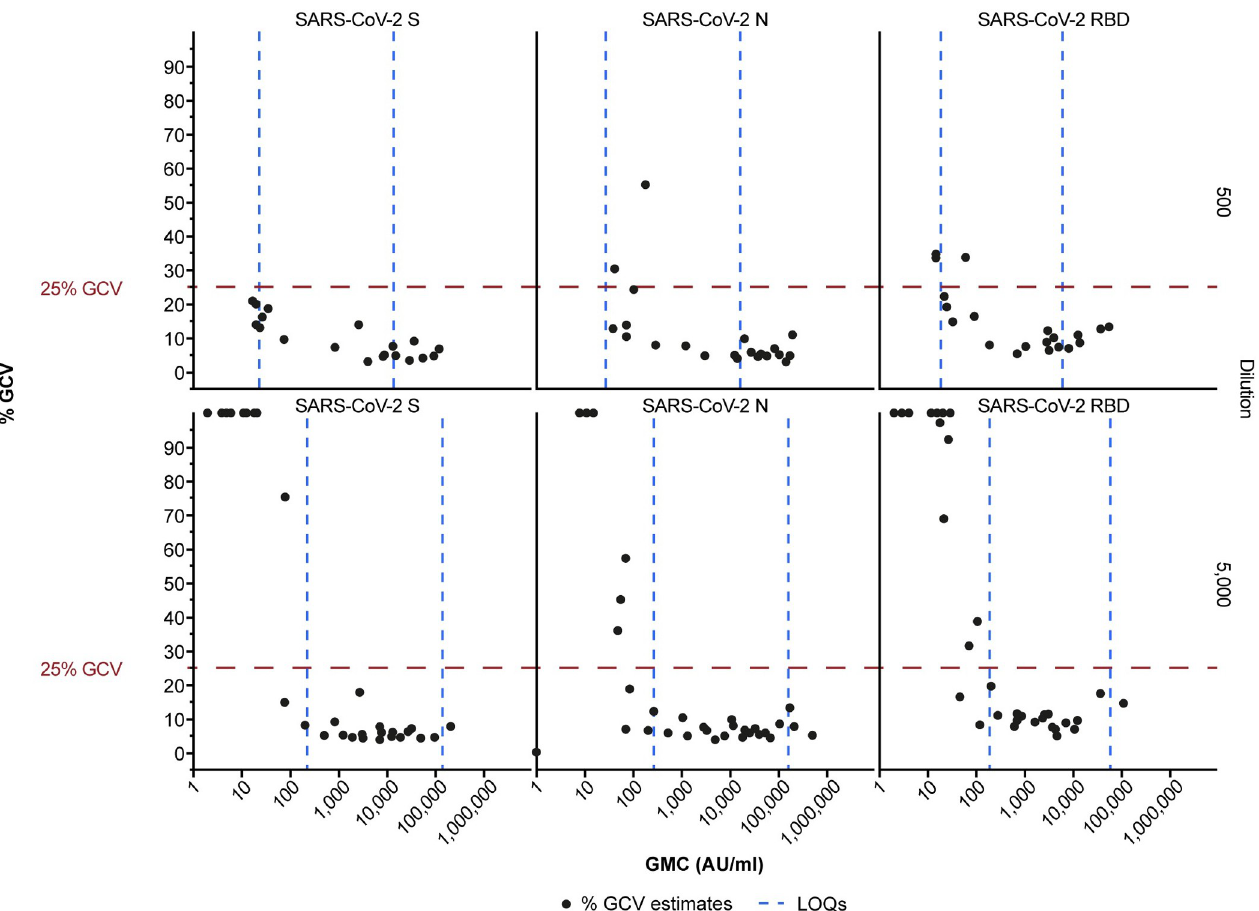
Fig 3. Anti-SARS-CoV-2 antibody MSD ECL assay precision. Precision profiles are shown for each of the three antigens in the assay, SARS-CoV-2 spike (SARS-CoV-2 S), nucleocapsid (SARS-CoV-2 N), and receptor-binding domain (SARS-CoV-2 RBD) across increasing geometric mean Ab[C]s (across 15 runs); precision profiles for quality control samples are also shown. The horizontal red dashed line represents the pre-defined %GCV criterion of � 25%. GMC values that exceeded the X-axis are displayed as the minimum or maximum value. %GCV values that exceeded the Y-axis maximum value are displayed at the top of the graph. The LLOQ and ULOQ are shown by vertical dashed lines. AU = arbitrary units; GMC = geometric mean concentration; %GCV = percent geometric coefficient of variation; LLOQ = lower limit of quantitation; LOQ = limit of quantitation; SARS-CoV-2 = severe acute respiratory syndrome coronavirus 2; ULOQ = upper limit of